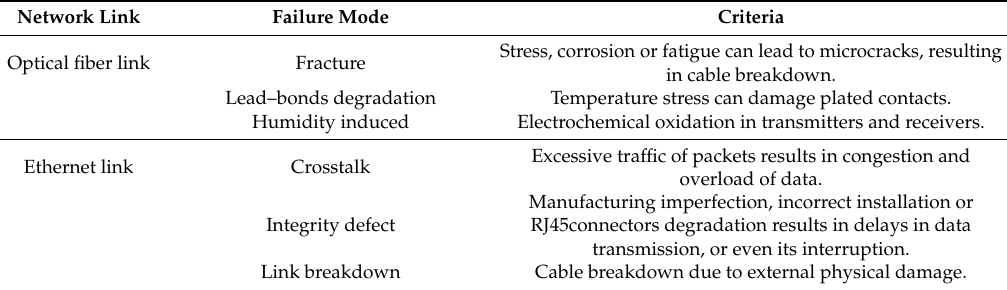
Table 9. Failure modes for network link considered for